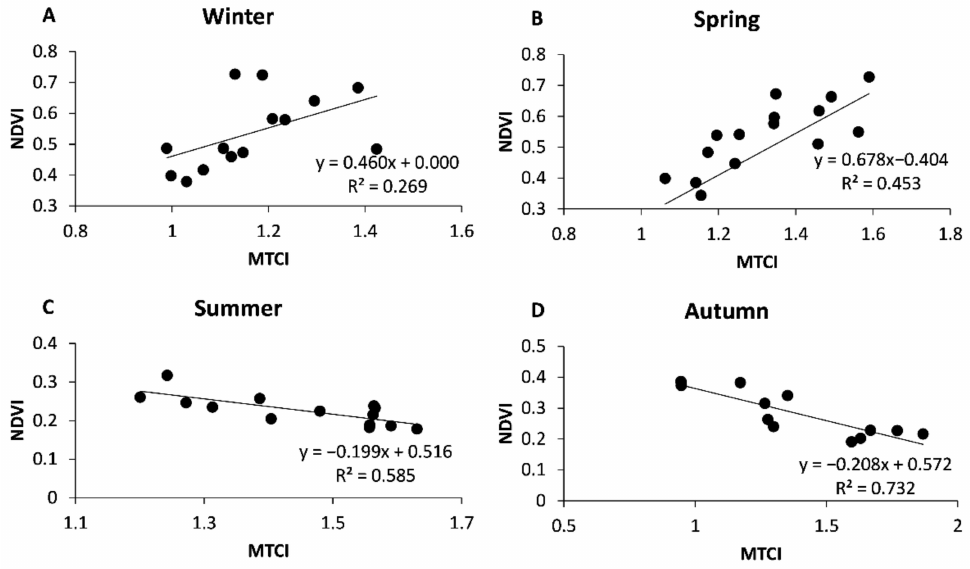
Figure 6. Linear regression of herb VIs per season: (winter ( A ), spring ( B ), summer ( C ) and autumn ( D )).